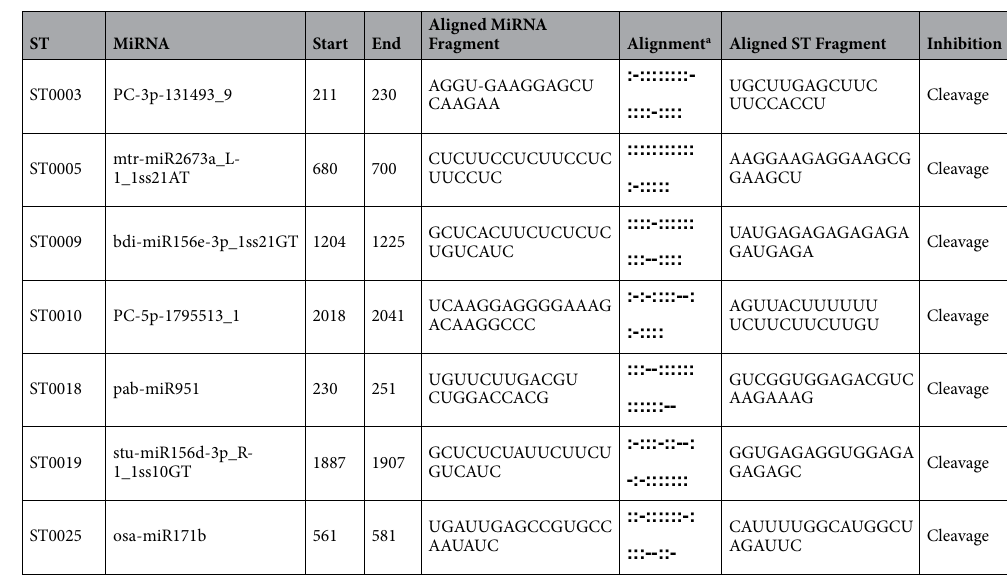
Table 2. List of miRNAs targeting the overlapped regions of STs. a “ : ”: match; “-”: mismatch.